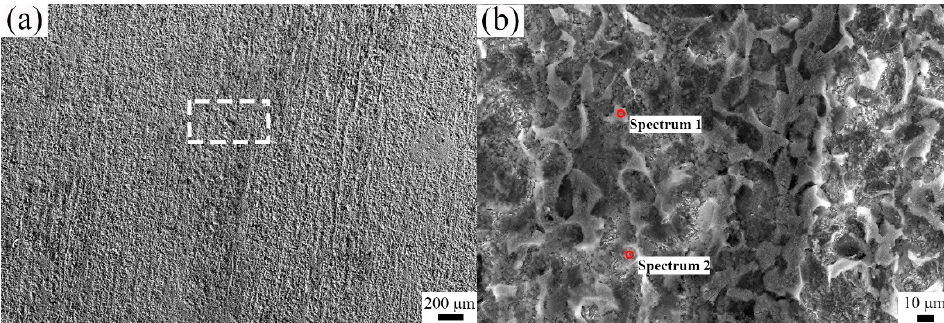
Figure 6. ( a ) SEM image of the corrosion scale of L245N standard steel and ( b ) the enlarged image of the selected area marked in ( a ) after 2 days of testing. Table 4. EDS results of corrosion scale formed on L245N standard steel after 2 days of testing, (at. %). The spectrum labels correspond to Figure 6b.